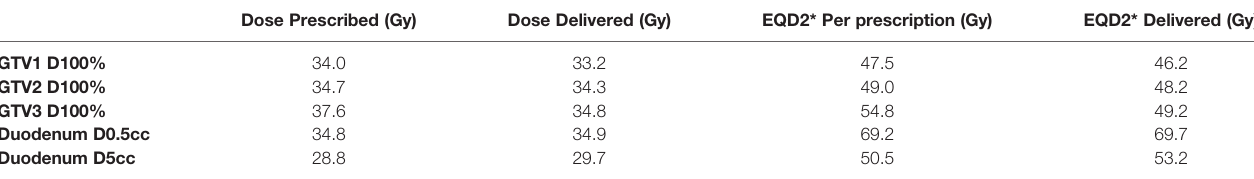
TABLE 1 | Case example 3: DVH parameters for planned versus accumulated dose from online adaptive treatment plans (total dose delivered with fi ve fractions SBRT). Dose Prescribed (Gy) Dose Delivered (Gy) EQD2* Per prescription (Gy) EQD2* Delivered